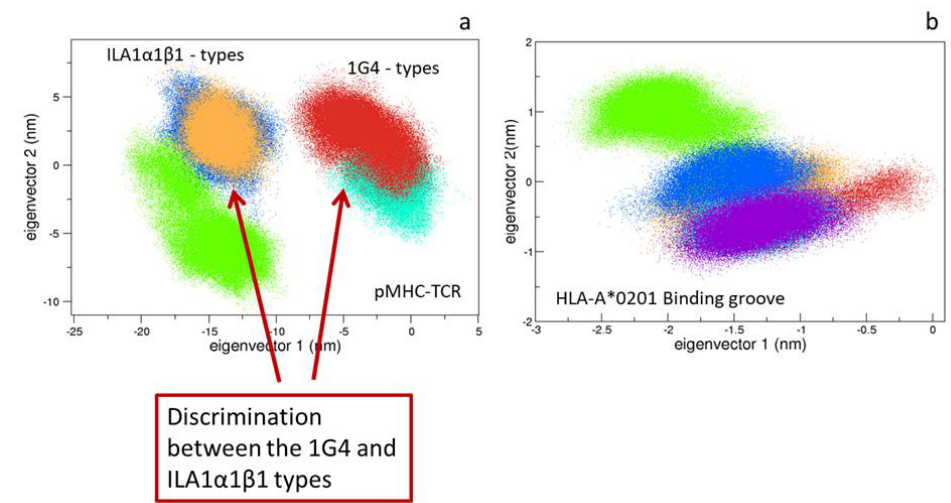
Figure 4. Comparison between the bound states. The projections on the common essential subspaces, defined by the two principal eigenvectors are shown. On the left ( a ), the 2D projections computed on the alpha carbons. On the right ( b ), the 2D projections of the Binding groove (1G4-ESO9C in red, 1G4-